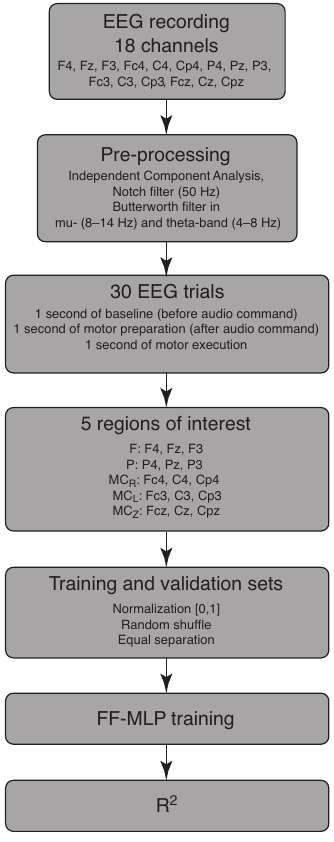
Figure 2. The block scheme of the research